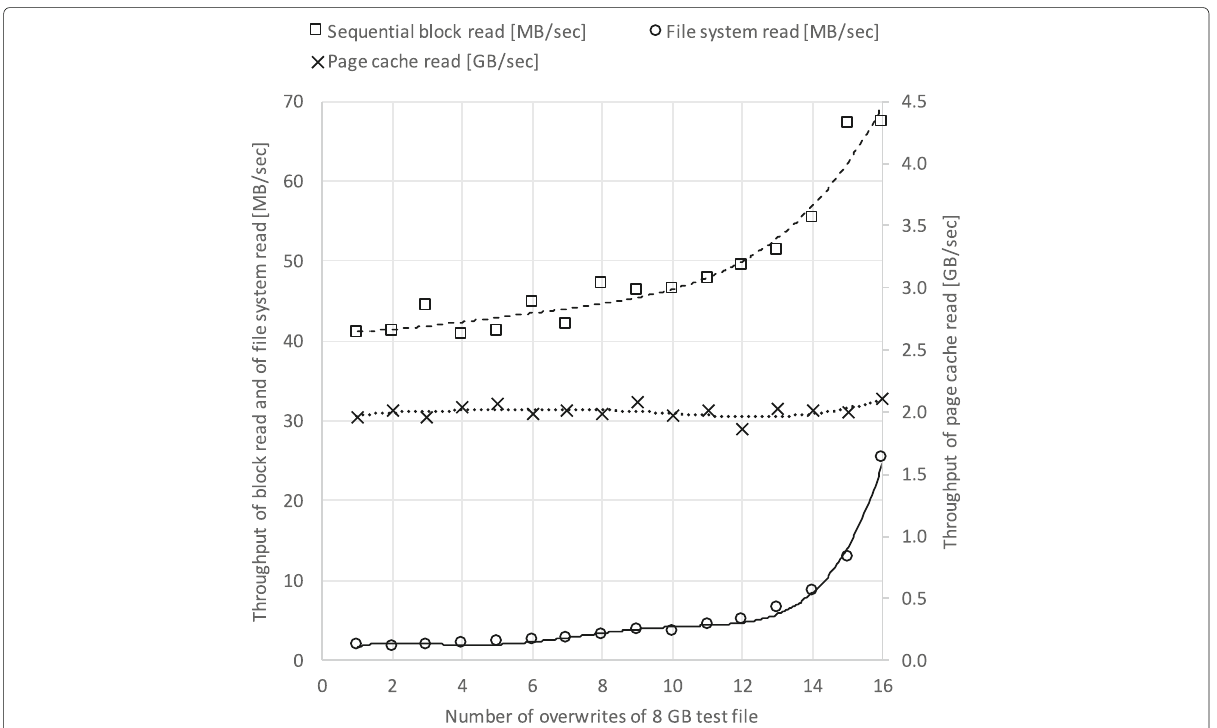
Fig. 13 Throughput of the LogDrive restoration driver